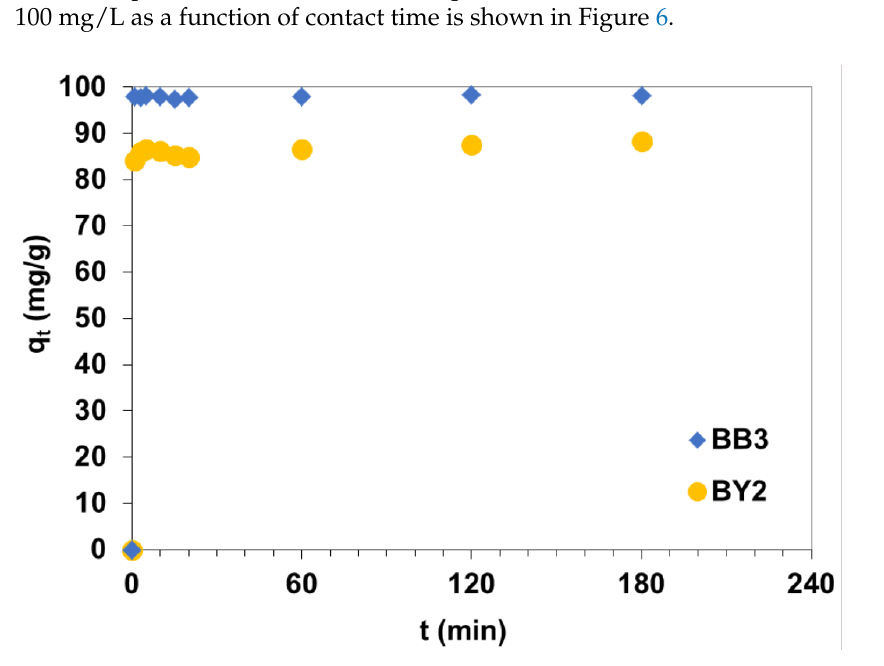
Figure 6. Influence of phase contact time on BB3 and BY2 uptake by C/SiO 2 from aqueous solutions of the initial concentration 100